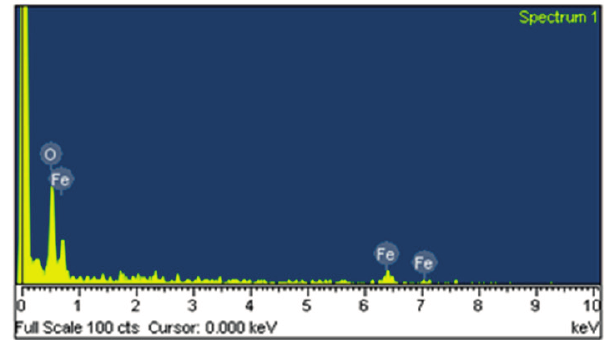
O measured by energy dispersive 2 3